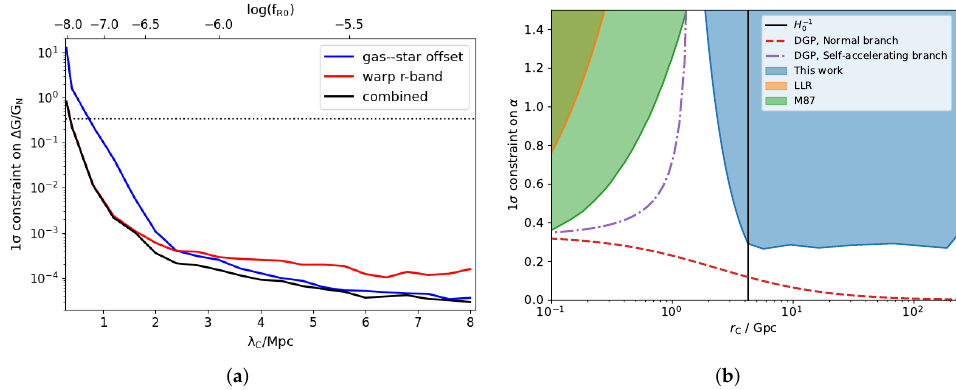
Figure 7. ( a ) Constraints on a thin-shell-screened fifth force from displacement between the centres of emission of optical and HI light in galaxies (i.e., separation of stars and gas), and stellar warps observed in the r -band. λ C is the Compton wavelength of the scalar, ∆ G / G N ≡ 2 β 2 and the horizontal dashed line marks ∆ G / G N = 1/3 in f ( R ) gravity. Reproduced from [185]. ( b ) Constraints on the Galileon coupling coefficient (on the plot denotes by α ) as a function of the theory’s crossover scale. The orange region is excluded by Lunar Laser Ranging, the green region from the position of the supermassive black hole in M87, and the blue region from a statistical analysis of the black hole positions in field galaxies. Reproduced from